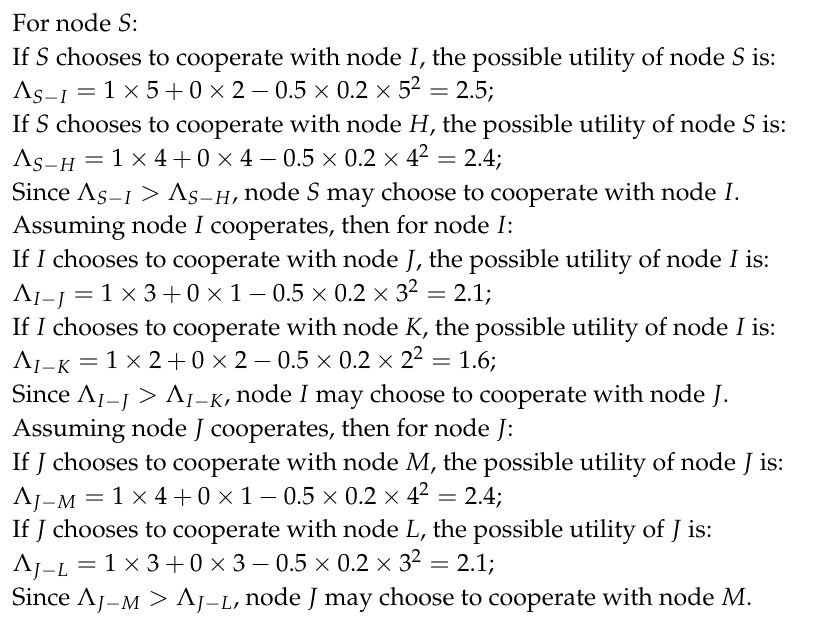
Figure 2. Selection of relay nodes.